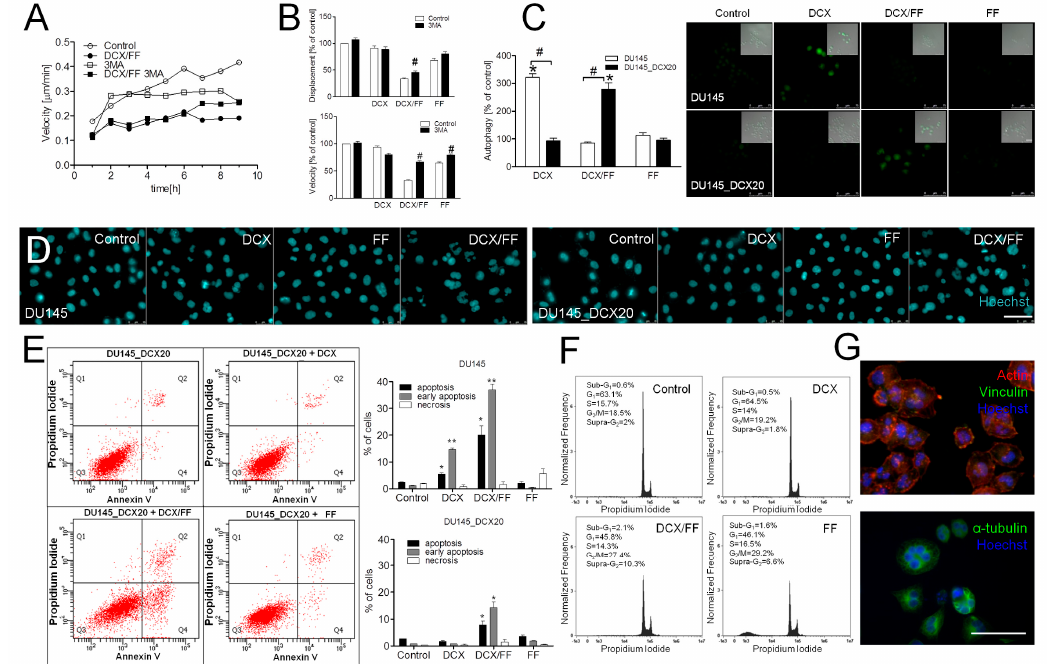
Figure 5. Combined DCX/FF treatment induces autophagy in DCX-resistant DU145. ( A ) Exemplary instantaneous speeds of single DU145_DCX20 cells estimated with time-lapse videomicroscopy (for 9 h) immediately after the administration of DCX and/or FF in the presence/absence of 0.5 μ M 3-methyladenine (3MA). ( B ) Averaged motility and displacement of DCX- and DCX/FF-treated DU145_DCX20 cells in the presence/absence of 3MA (plotted as % of control). ( C ) DU145 and DU145_DCX20 cells were subjected to DCX and/or FF for 48 h and the activity of autophagosomes was visualized by autophagy detection kit. ( D ) DU145 and DU145_DCX20 cells were cultivated as in ( C ) and stained with Hoechst33258 to visualize their nuclei by fluorescence microscopy. ( E ) Pro-apoptotic activity of DCX and/or FF was estimated in DU145_DCX20 populations after 72 h with annexinV/PI assay and compared with pro-apoptotic activity of DCX/FF on DU145 cells (right panel). ( F ) DU145_DCX20 cells were cultivated as in ( C ) for 48 h and stained with propidium iodide in the presence of rybonucleaseA. DNA contents were estimated by FACS. ( G ) Morphology of polyploid cells in DCX/FF-treated populations of DU145_DCX20 cells stained against F-actin, vinculin and α - tubulin. Histograms and compensated dot-plots comprise 30,000 and 50,000 events, respectively, classified based on their bright field ratios and nuclear contrast. Error bars represent SEM. Statistical significance was analyzed with t-Student test vs. non-treated DU145 control ( B ; * p ≤ 0.05), DCX/FF- treated control ( B ) or with the variant indicated by the brackets ( # p ≤ 0.05). Scale bar: 50 µm. Note DCX/FF-induced autophagy in DU145_DCX20 cells and their relatively low resistance to DCX/FF- induced apoptosis.